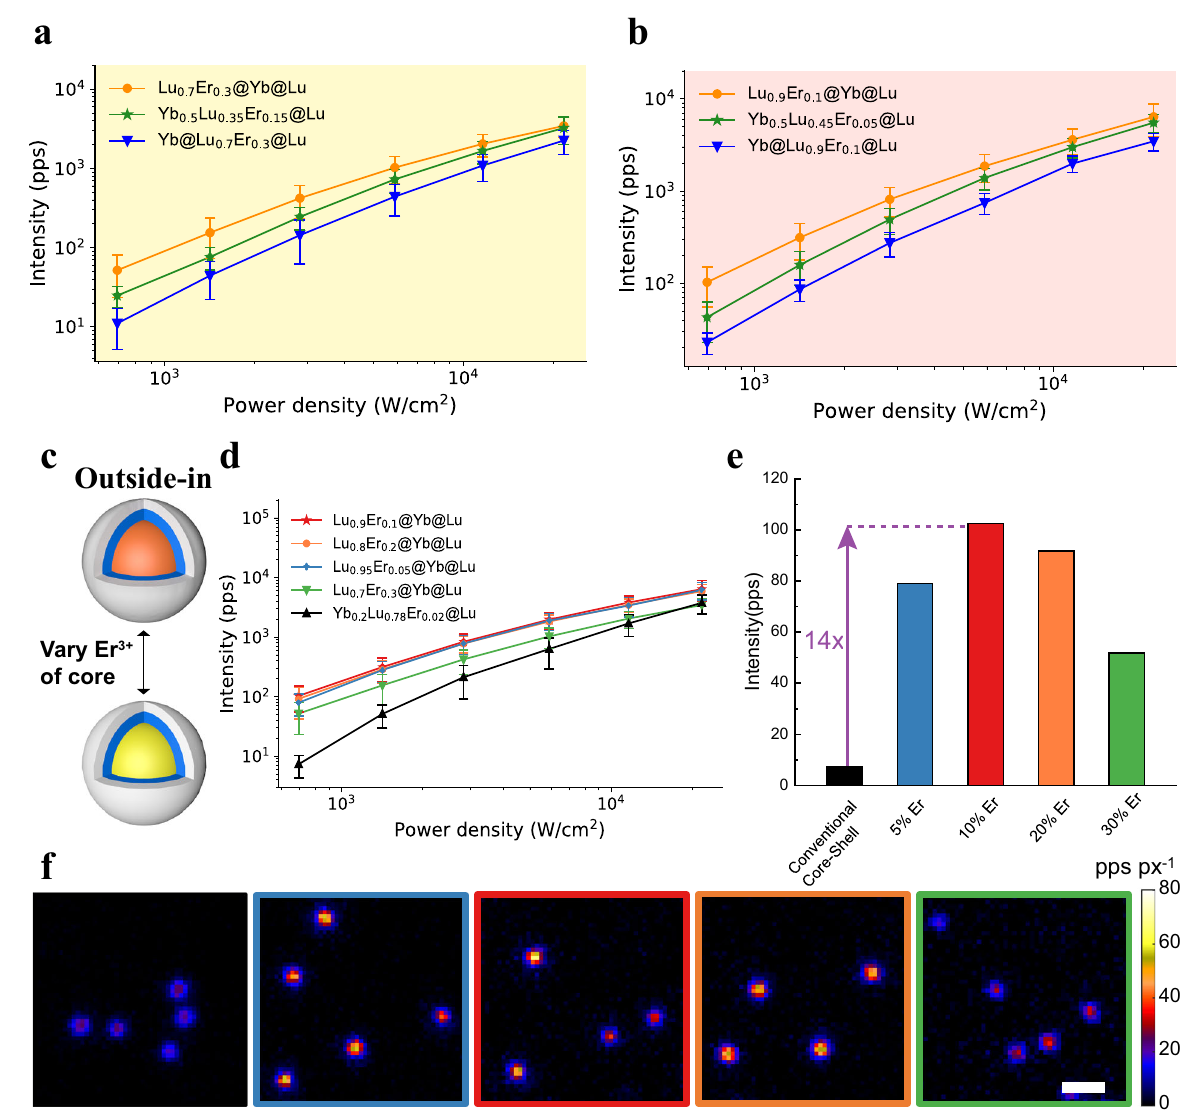
Fig. 6 | Effect of varying the doping concentration of Er 3+ ions in the core. a Saturation curves of single-particle brightness of UCNPs with 30% Er 3+ doping. b Saturation curves of single-particle brightness of UCNPs with 10% Er 3+ doping. c Schematic diagram of changing the doping concentration of Er 3+ ions in core. d Saturation curves of single-particle brightness for outside-in architectures with different Er 3+ doping concentrationsincoreand conventionalcore-shellUCNPs ( β - Lu 0.78 Yb 0.2 Er 0.02 @Lu) of same size. The results of a-d were presented as means ± standard deviation (two independent experiments, more than fi ve fi eld of views wide- fi eld images were acquired for each experiment; Lu 0.7 Er 0.3 @Yb@Lu: n